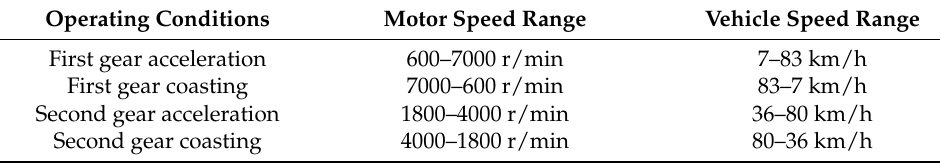
Table 1. Vehicle noise test conditions.